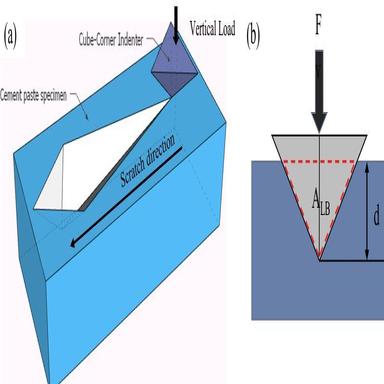
(a) Schematic illustration of a scratch test with the cube-corner indenter and (b) its section view. Here, Fv is the vertical load, d is the sctrach depth, and ALB is the projected horizontal load bearing contect area.